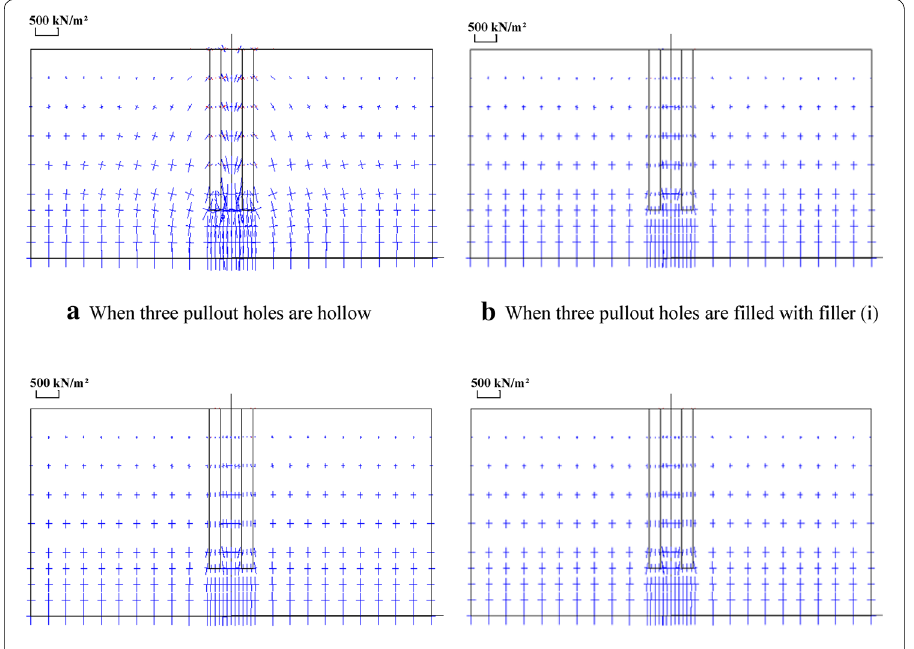
Fig. 8 Principal stress of surrounding ground when pullout holes are hollow and filled. a When three pullout holes are hollow. b When three pullout holes are filled with filler (i). c When three pullout holes are filled with filler (ii). d When three pullout holes are filled with filler